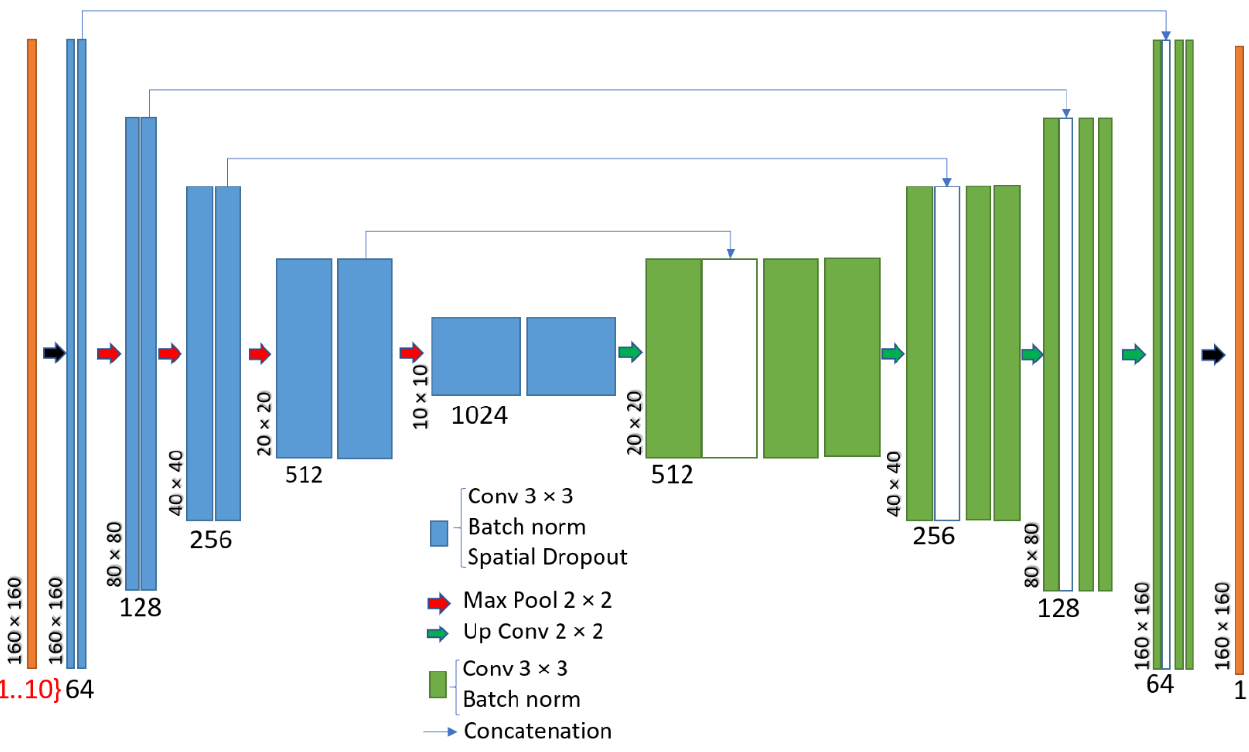
Figure 4. Deep convolutional neural network architecture (U-Net) used in this work.